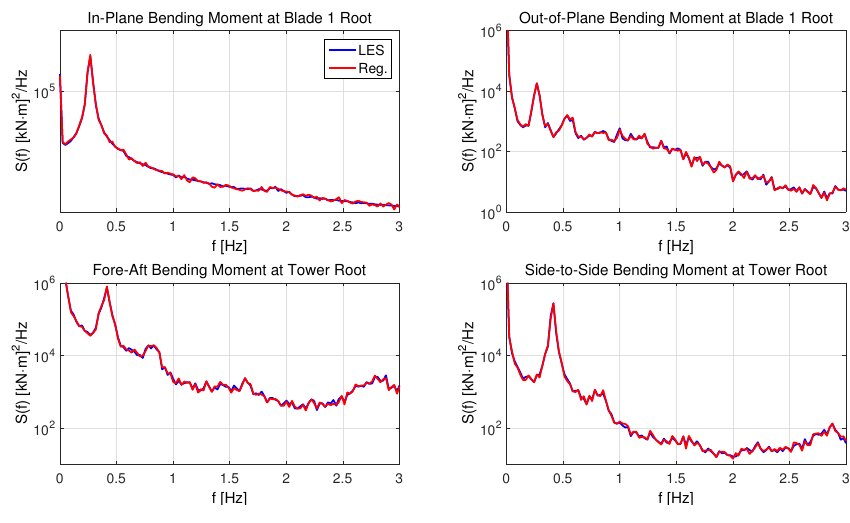
Figure 27. Spectra of turbine loads from simulated free stream.